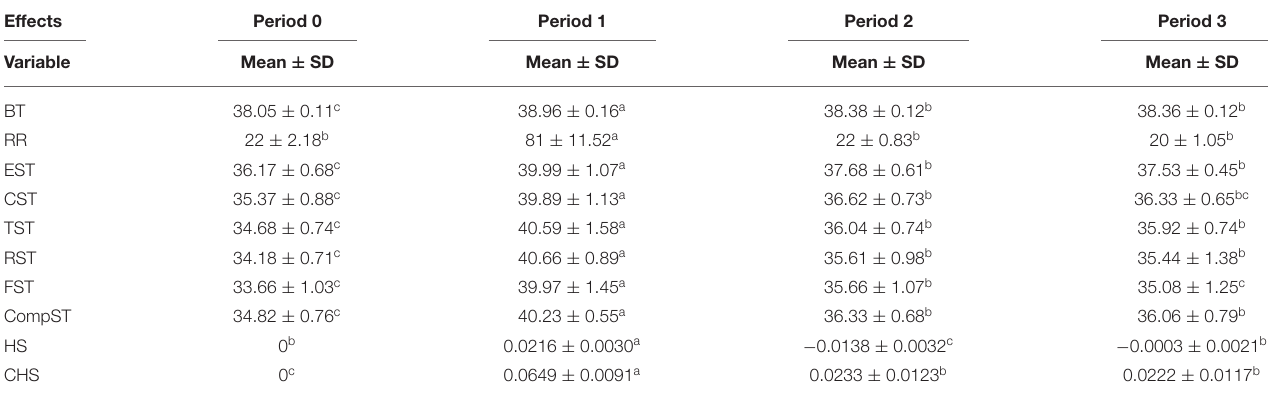
TABLE 1 | Mean and standard deviation of the physiological and biophysical variables assessed in adult female buffaloes in the Eastern Amazon during the HTT. Effects